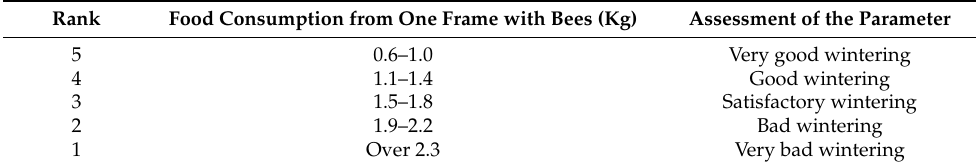
Table 1. Assessment of honey bee colony food consumption in the winter.